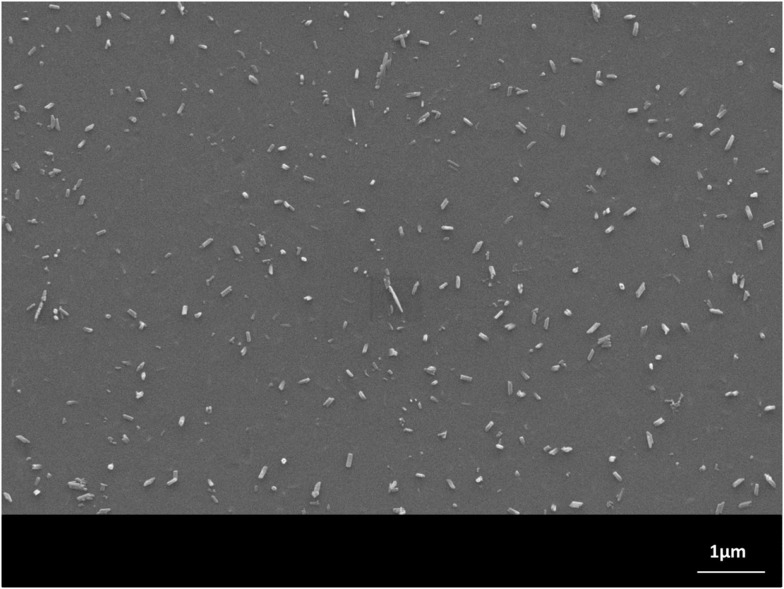
Microstructures of heat-treated glass frits of composition No. 5, processed at 900°C/h. Fractured surface, HF etched sample (10 s, 3% HF). SEM. The glass-ceramic contains needle-like Ca5(PO4)3F crystals.